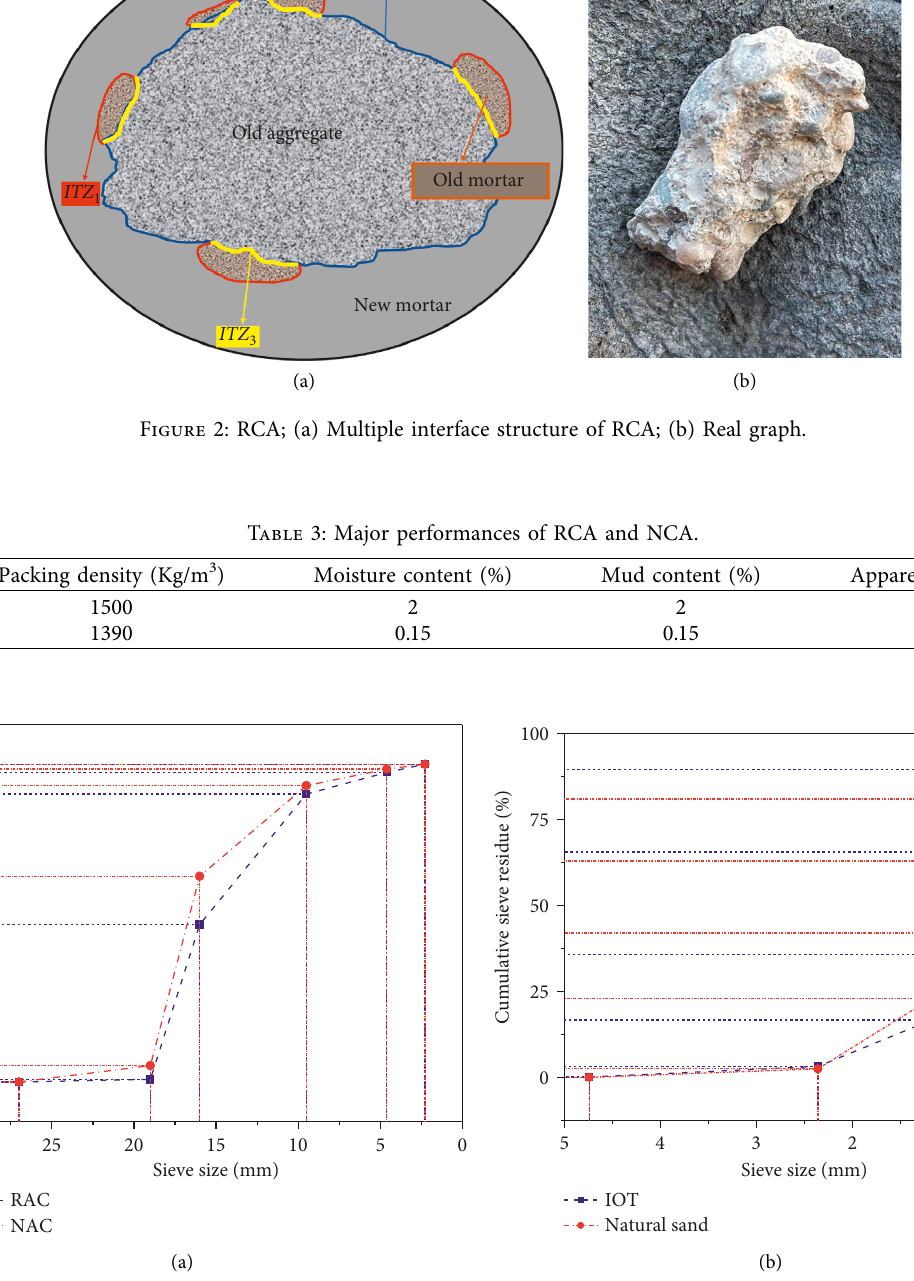
Figure 3: Coarse and fine aggregate gradation; (a) Coarse aggregate; (b) Fine aggregate. Table 4: Mixed proportions of